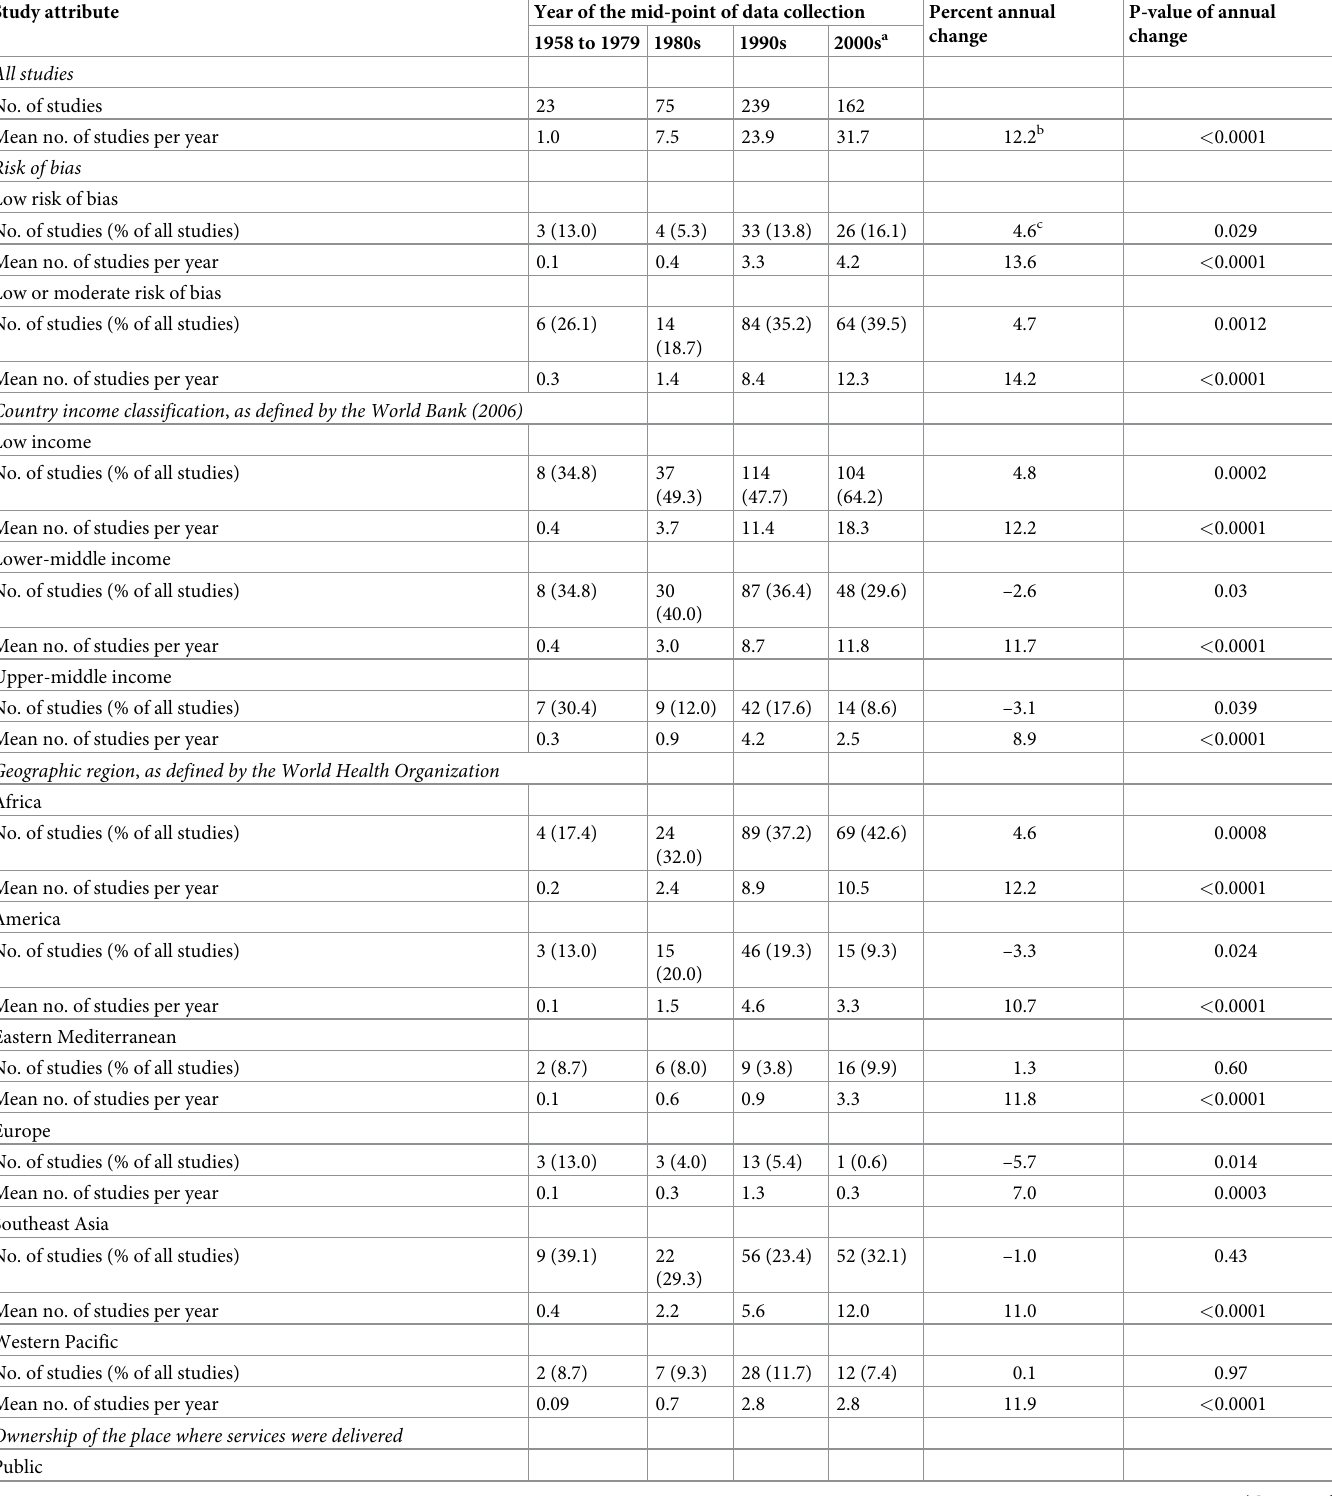
Table 8. Time trends in study